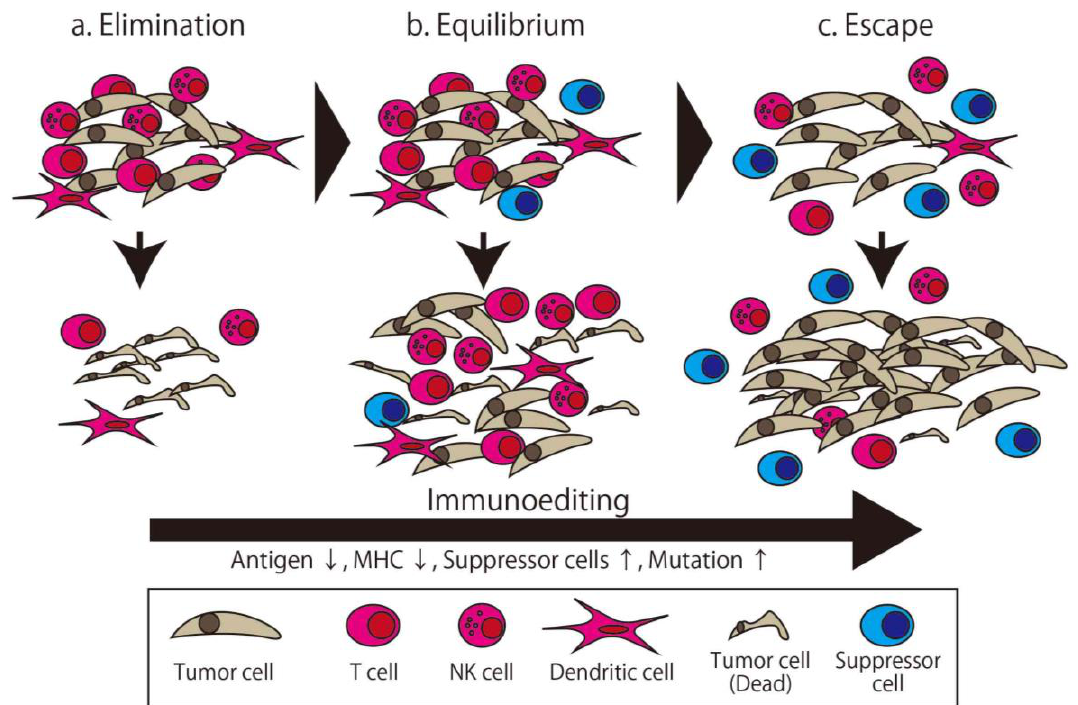
Figure 1. The three phases of cancer immunoediting. The tumor is gradually edited to gain resistance to immune attack. ( a ) In the Elimination phase, the tumor is eliminated by the immune attack. ( b ) In the Equilibrium phase, some of the edited tumor cells survive and are eliminated incompletely. ( c ) In the Escape phase, highly edited tumor cells can proliferate. The apparent clinical cancer is in the Escape phase.